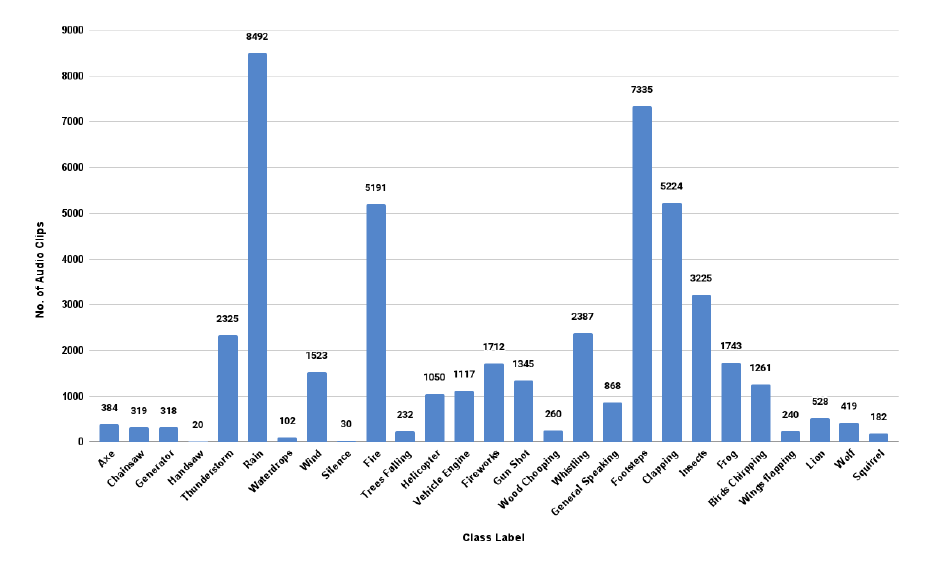
Figure 6. The number of audio samples per class.